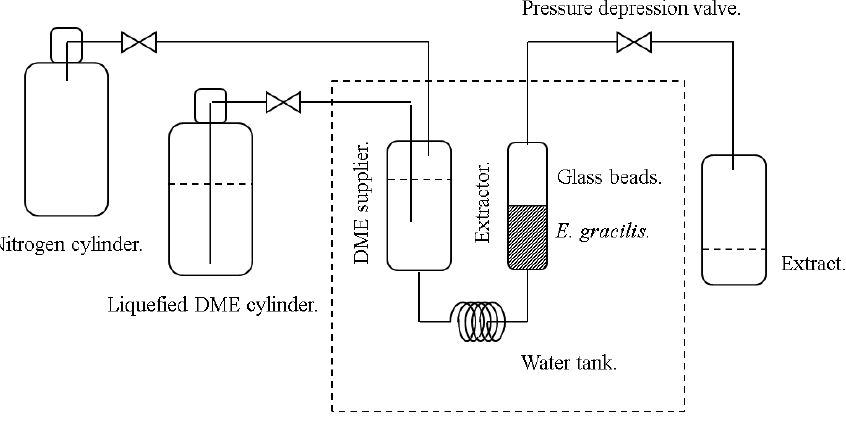
Figure 5. Schematic diagram of the DME extraction